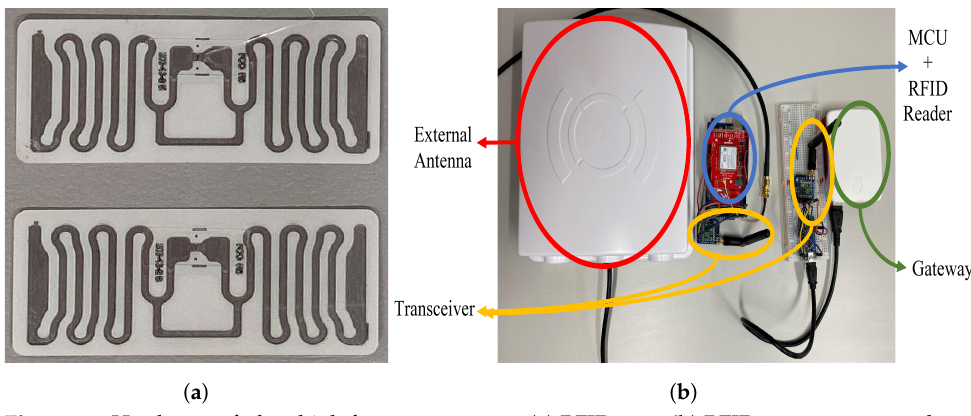
Figure 11. Hardware of ultra-high frequency system ( a ) RFID tags, ( b ) RFID system put together.